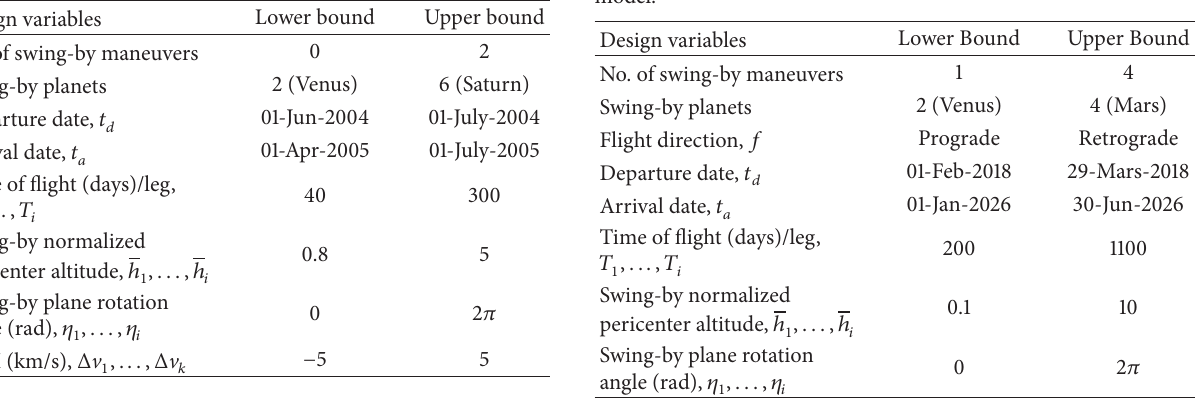
Table 4: Bounds of Earth-Mars mission’s design variables: first step.